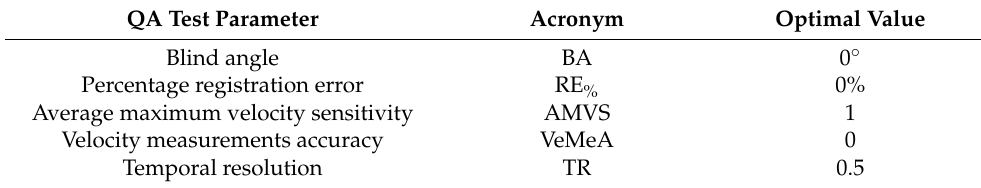
Table 7. Summary of the optimal values for each proposed test parameter. QA Test